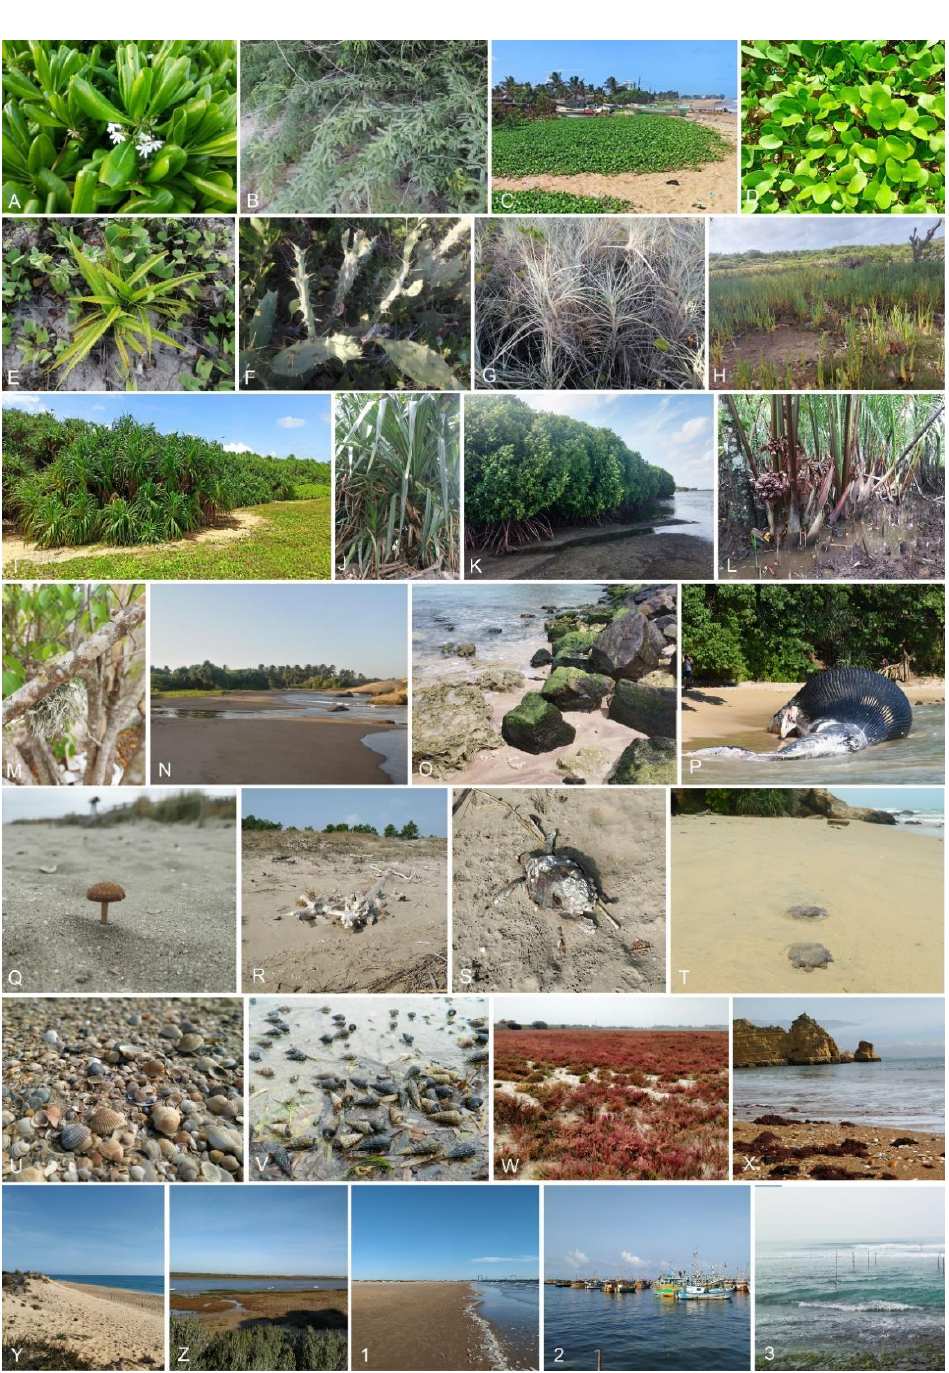
Figure 4. Different habitats hosting fungal marine fungi: ( A – J , M ), terrestrial-coastal ecosystems. ( K , L , N – 1 ), semi-coastal marine ecosystems. ( 2 , 3 ), coastal marine ecosystems. Credit: pictures ( C , D , I ), M.P. Hendawitharana.